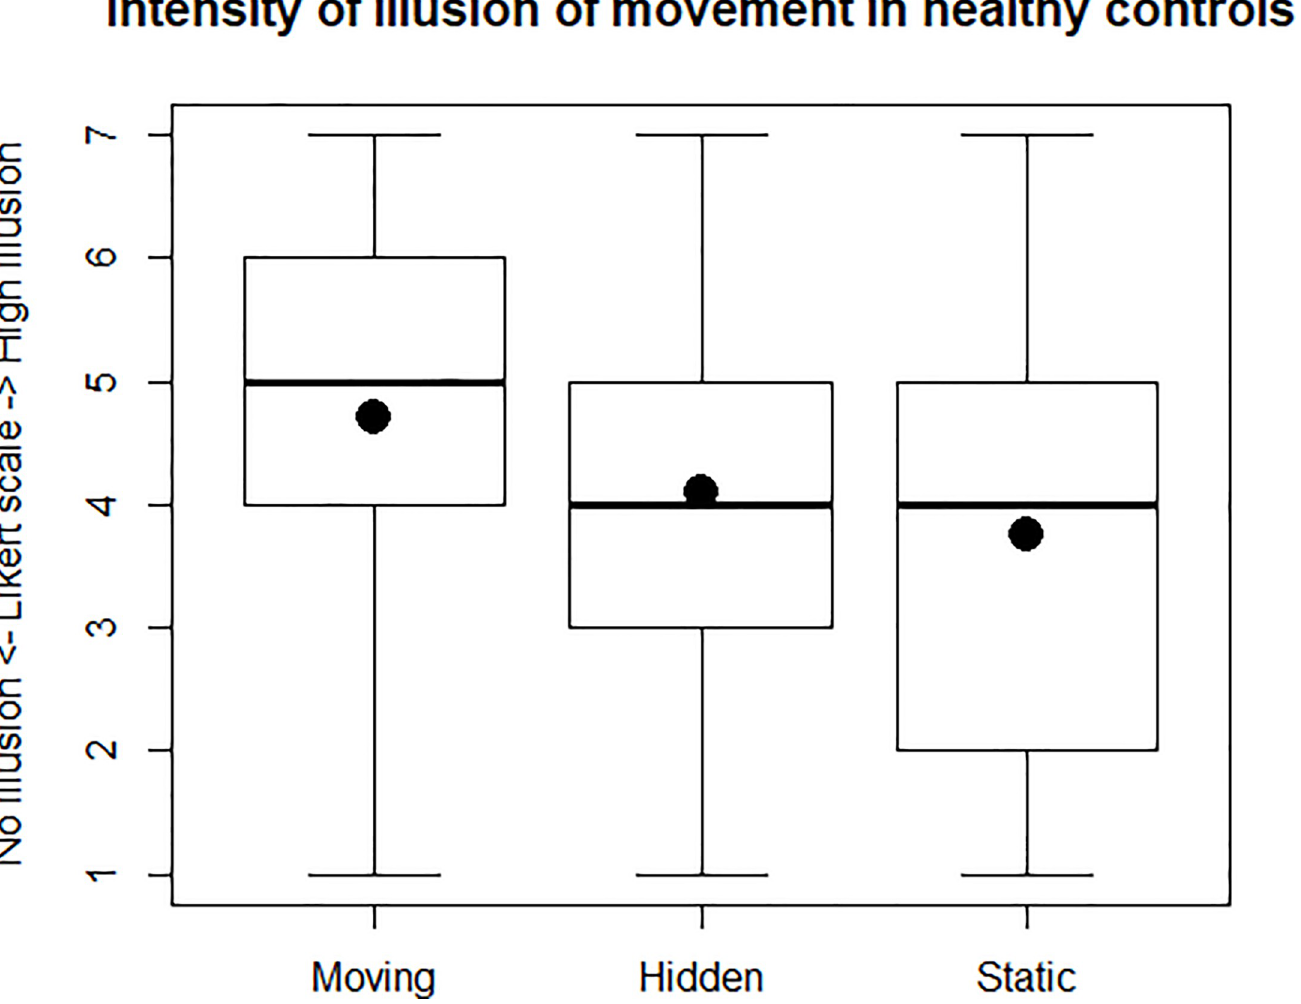
Fig 6. Intensity of illusion of movement. Boxplot about intensity of illusion of movement felt for each condition, averaged in all healthy controls (respectively for Moving, Hidden, Static condition). Likert scale from 1 to 7: 1 means “no illusion”, 7 mean “very high intensity of illusion”. The dots represent the means.